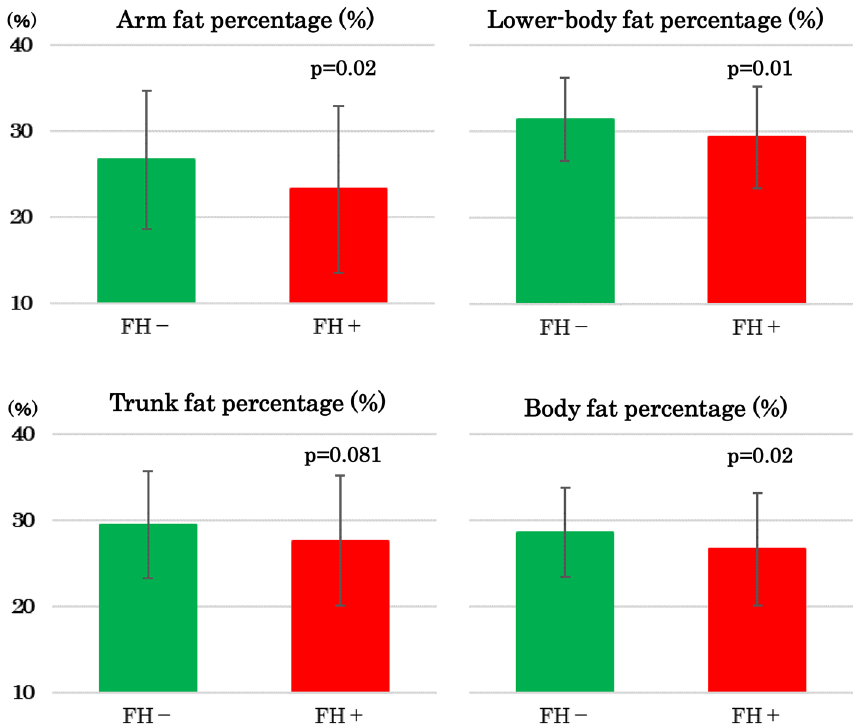
Figure 1. Fat percentage in arms, lower-body, trunk, and entire body in female nonathletes students in the presence (FH + , red columns, n = 55) and absence (FH-, green columns, n = 148) of family history of type 2 diabetes. Lower-body includes gluteal and leg (gluteofemoral) region. Note that differences in arms and lower- body were significant while that in trunk was